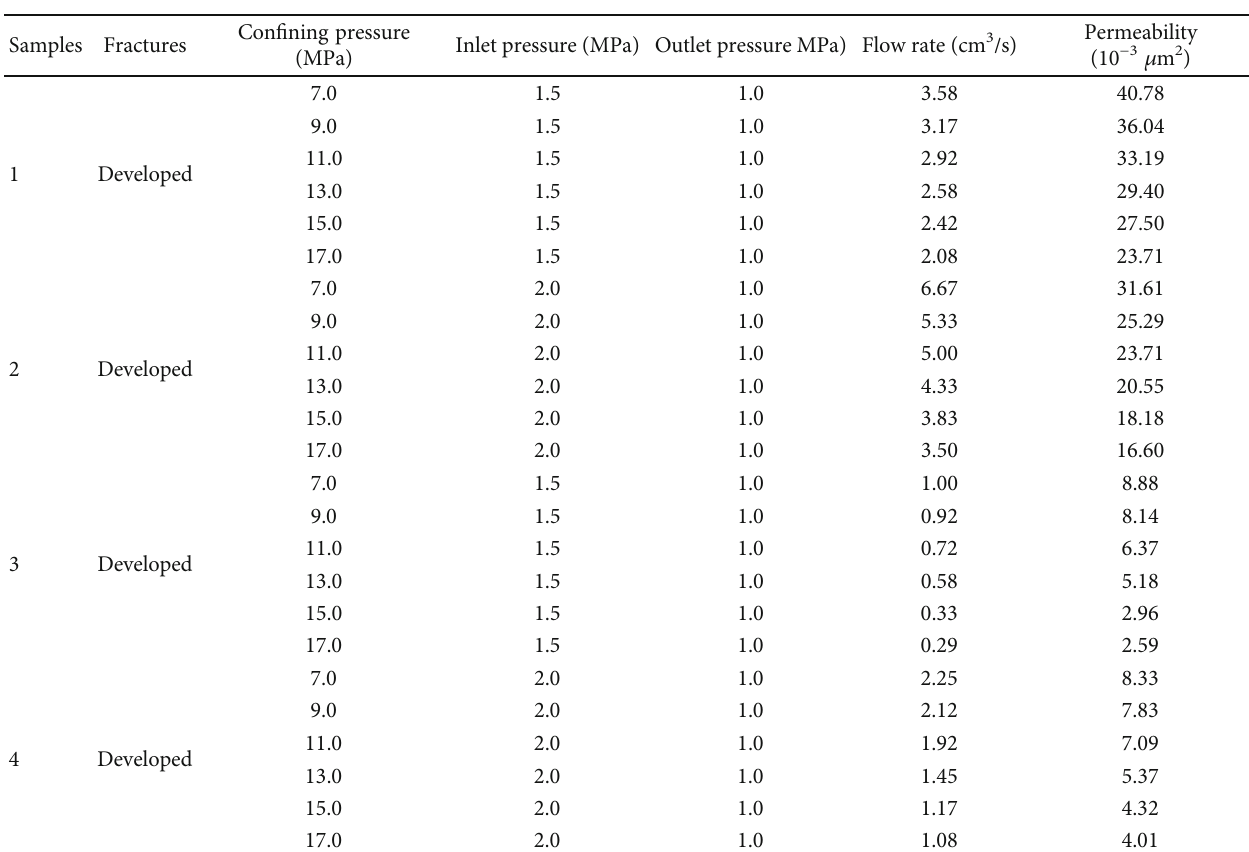
Table 4: Helium permeability test results of the